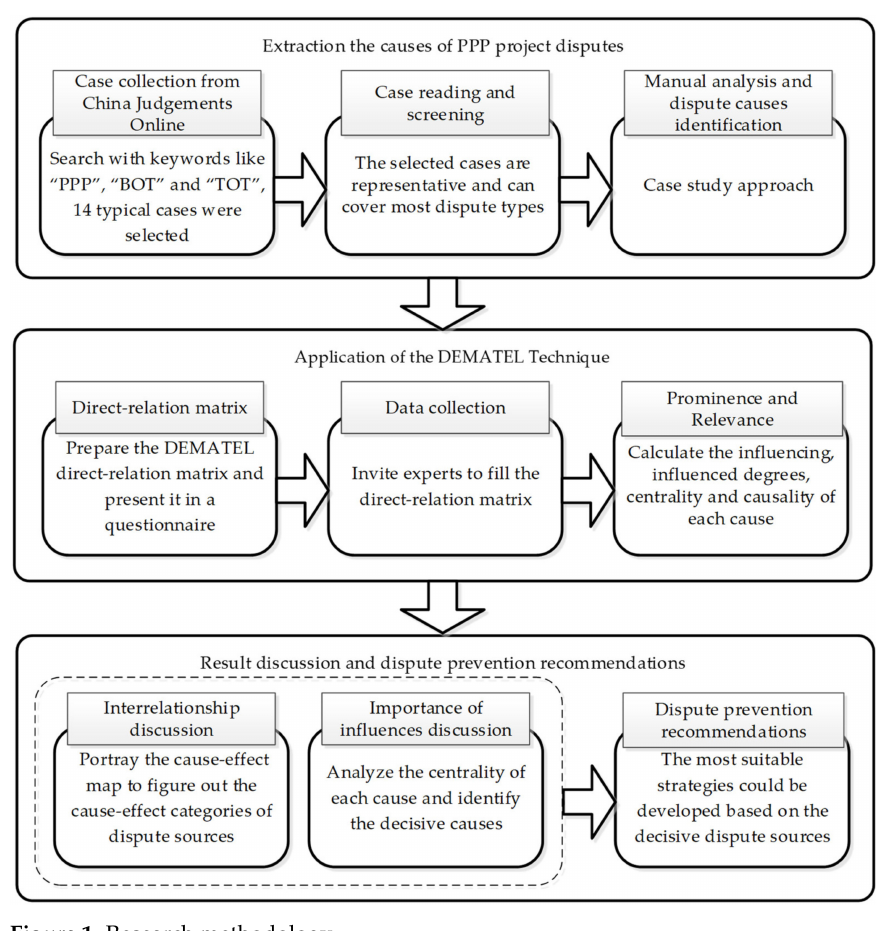
Figure 1. Research